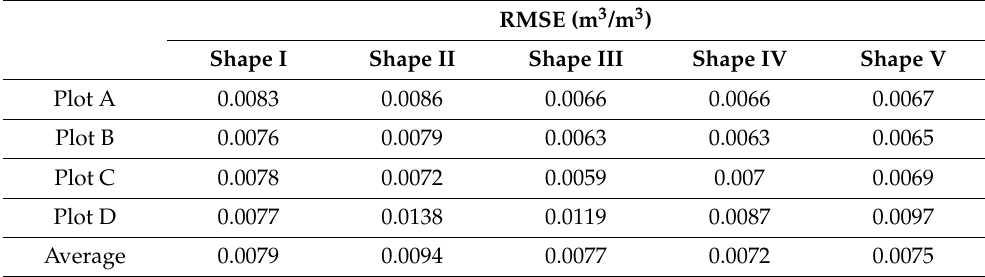
Table 1. Spatial distribution accuracy of soil moisture measurements in different survey line shapes for Plot